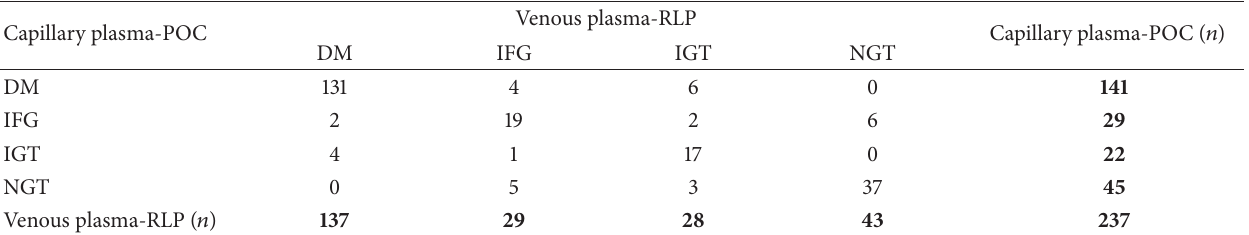
Table 2: Classification of glycaemia based on plasma glucose results measured with reference laboratory procedure (RLP) and point-of-care (POC) glucose testing, according to the 2006 WHO criteria for venous and capillary plasma [2]. Venous plasma-RLP Capillary plasma-POC Capillary plasma-POC ( 𝑛 ) DM IFG